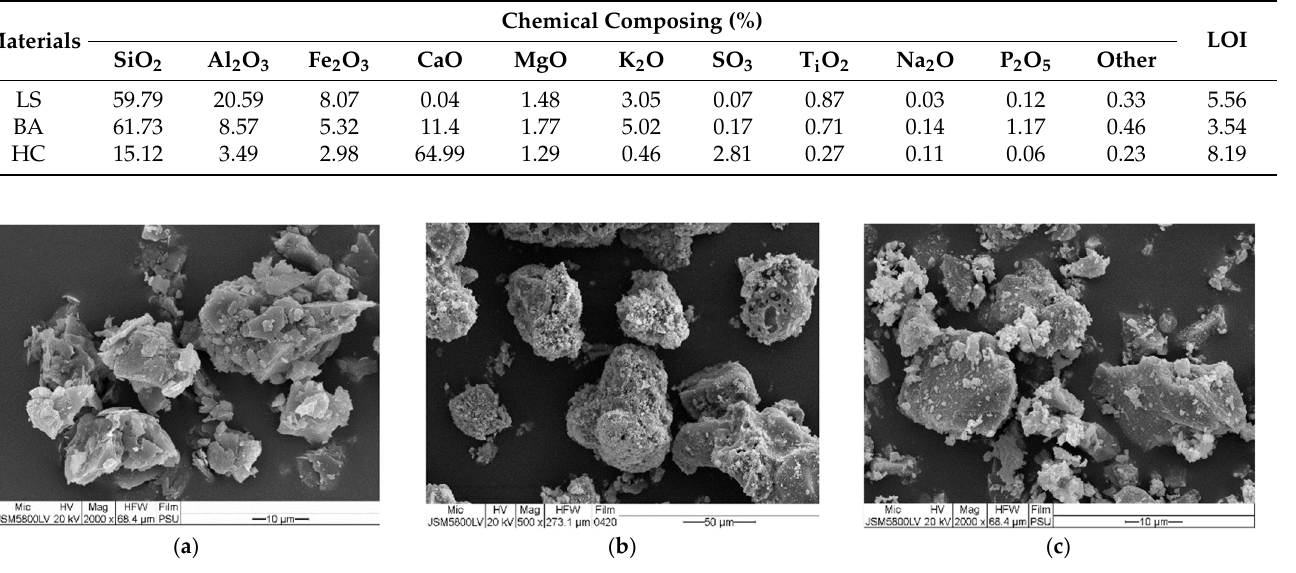
Figure 2. SEM images: ( a ) lateritic soil; ( b ) biomass bottom ash; ( c ) hydraulic cement. Table 2. Chemical compositions of the LS, BA, and HC.